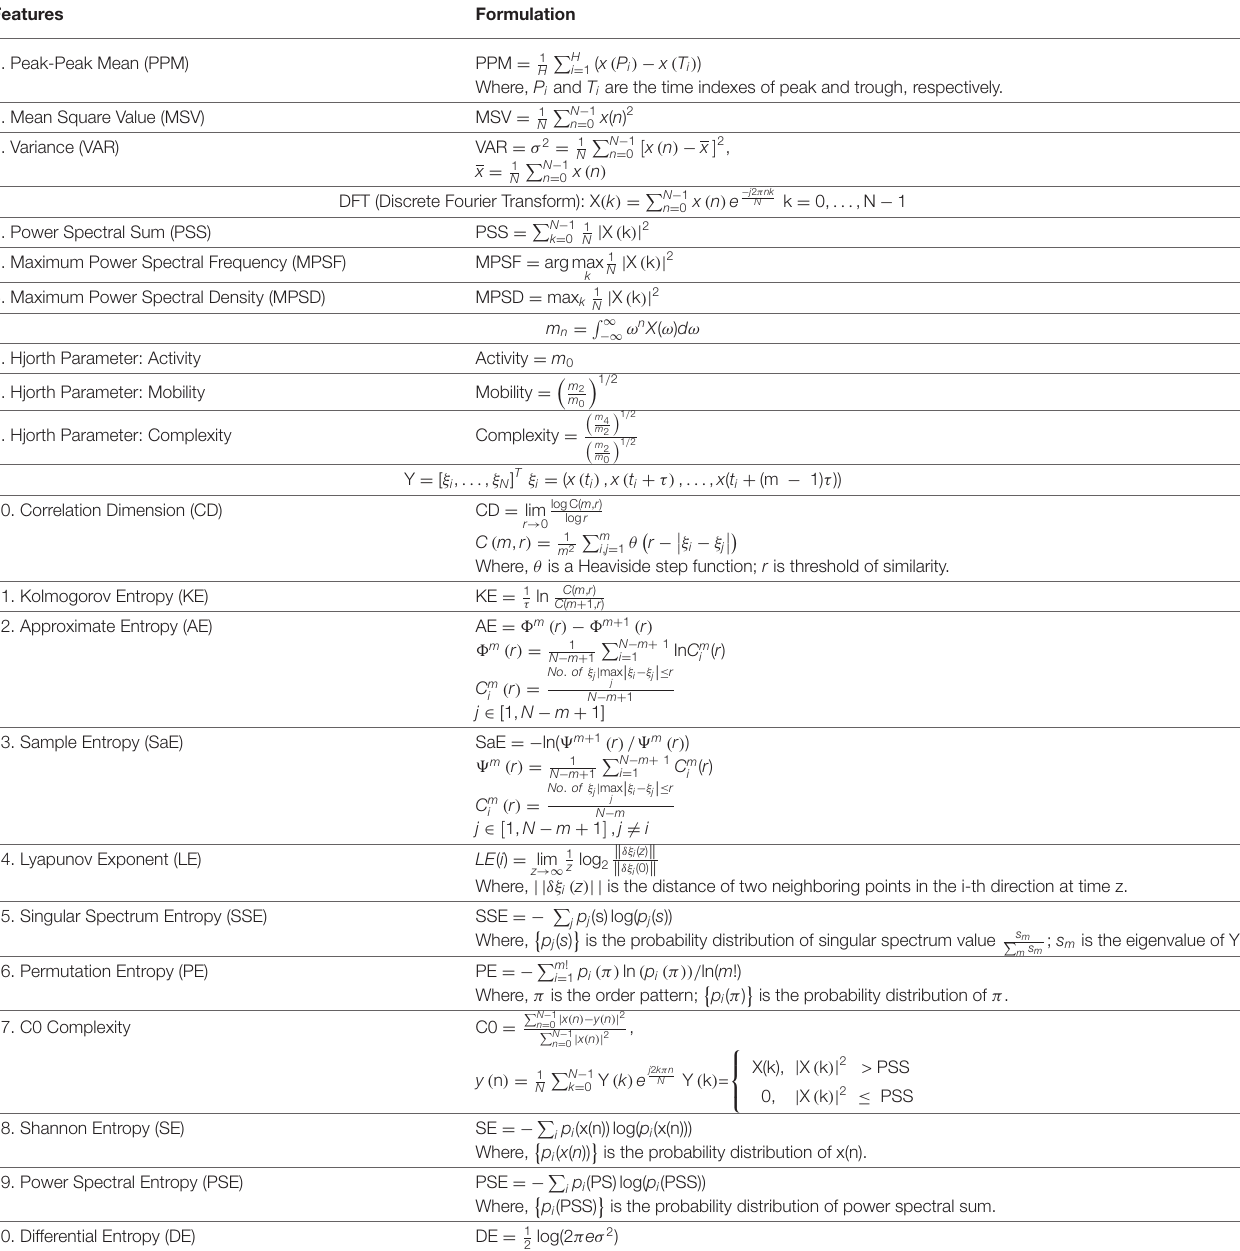
TABLE 1 | Handcrafted features used for autism spectrum disorder/typically developing (ASD/TD) classification.